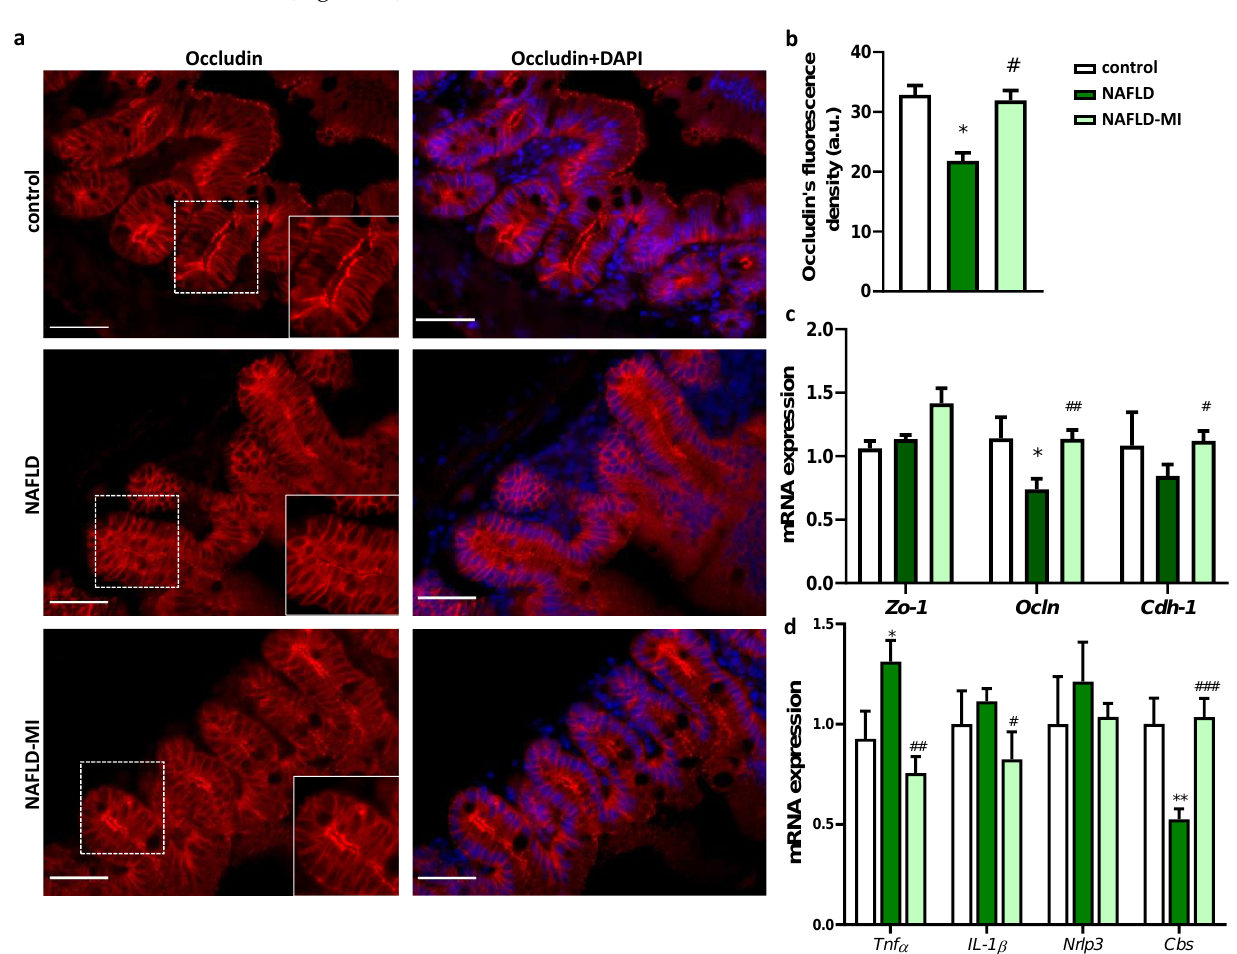
Figure 2. Effects of the MI treatment on intestinal permeability and inflammation. ( a ) Jejunum immunofluorescence of Occludin and DAPI. Bar = 50 µm. ( b ) Occludin’s fluorescence intensity. Effects of treatments on ( c ) mRNA expression of intestinal permeability-related genes: Zo-1 (Zonula Oclnudens-1), Ocln (Occludin), and Cdh-1 (Cadherin-1), on ( d ) mRNA expression of inflammatory and antioxidant related-genes: Tnfα (Tumor Necrosis Factor α), Il-1 β (interleukin 1β), Nlrp3 (NLR family pyrin domain containing 3), and Cbs (cystathionine- β -synthase). Data are mean ± SEM. * p < 0.05, ** p < 0.01 vs. control mice, # p < 0.05; ## p < 0.01; ### p < 0.001 vs. NAFLD mice.